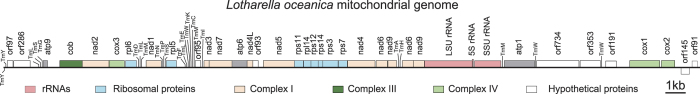
Physical map of the Lotharella oceanica mitochondrial genome.Colors correspond to predicted functional categories. Genes mapped on the upper side of the genome are transcribed right to left and those on the bottom, left to right.